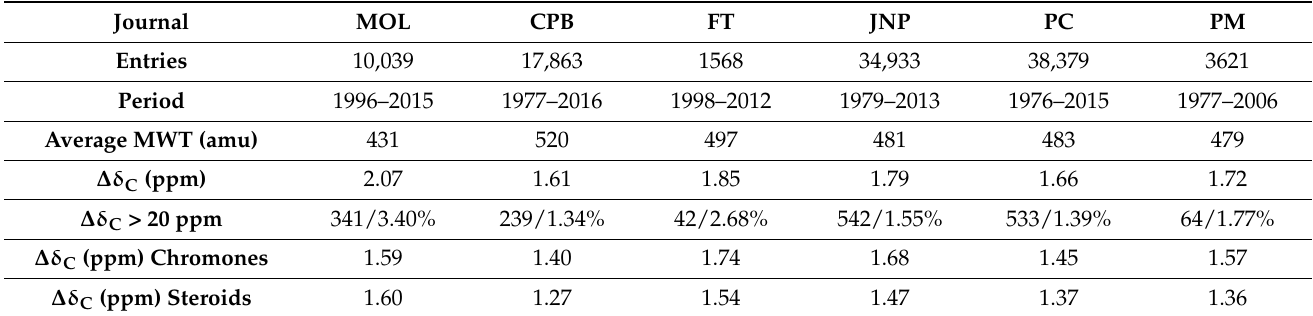
Table 1. Comparison of the quality of 13 C-NMR data published in Molecules (MOL) versus Chemical and Pharmaceutical Bulletin (CPB), Fitoterapia (FT), Journal of Natural Products (JNP), Phytochemistry (PC), and Planta Medica (PM).